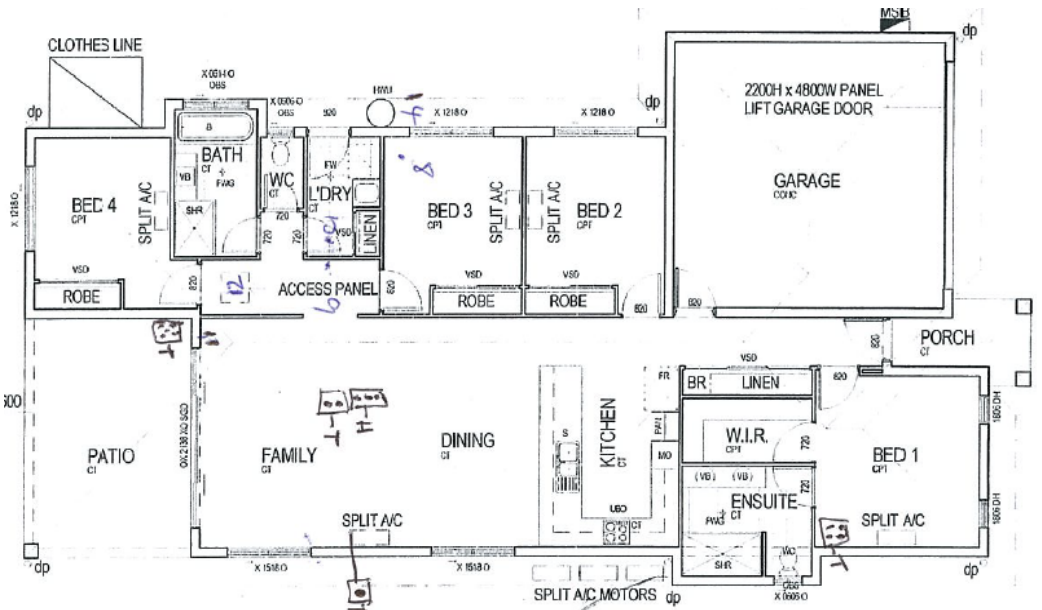
Figure 2. Case study floor plan with location of